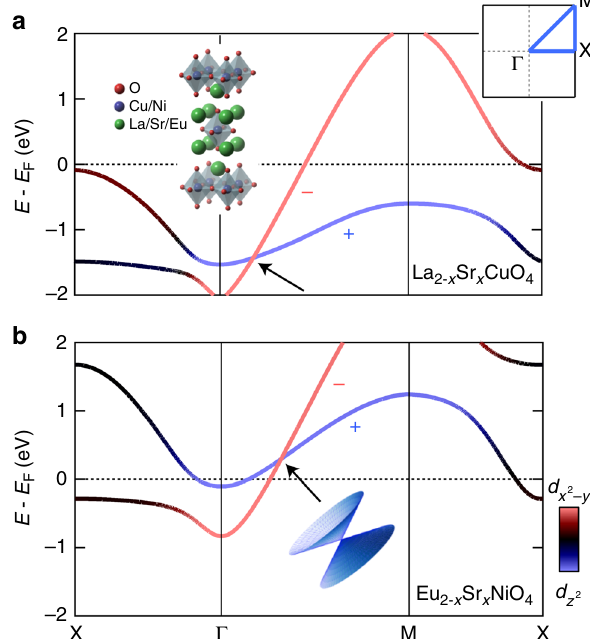
Fig. 1 Type-II Dirac points. Density functional theory calculated band